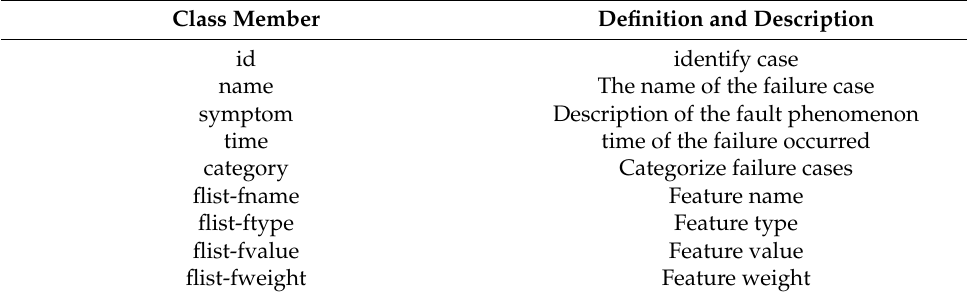
Table 1. Class template for fault case definition.